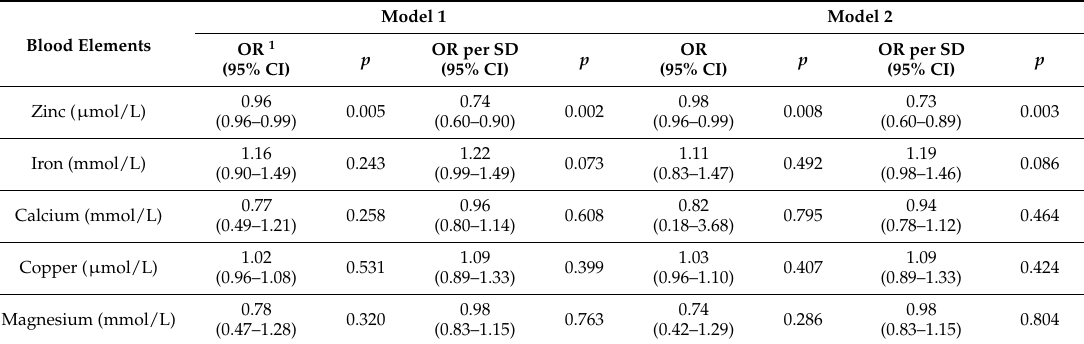
Table 6. Odds ratio (95% CIs) of ADHD for blood